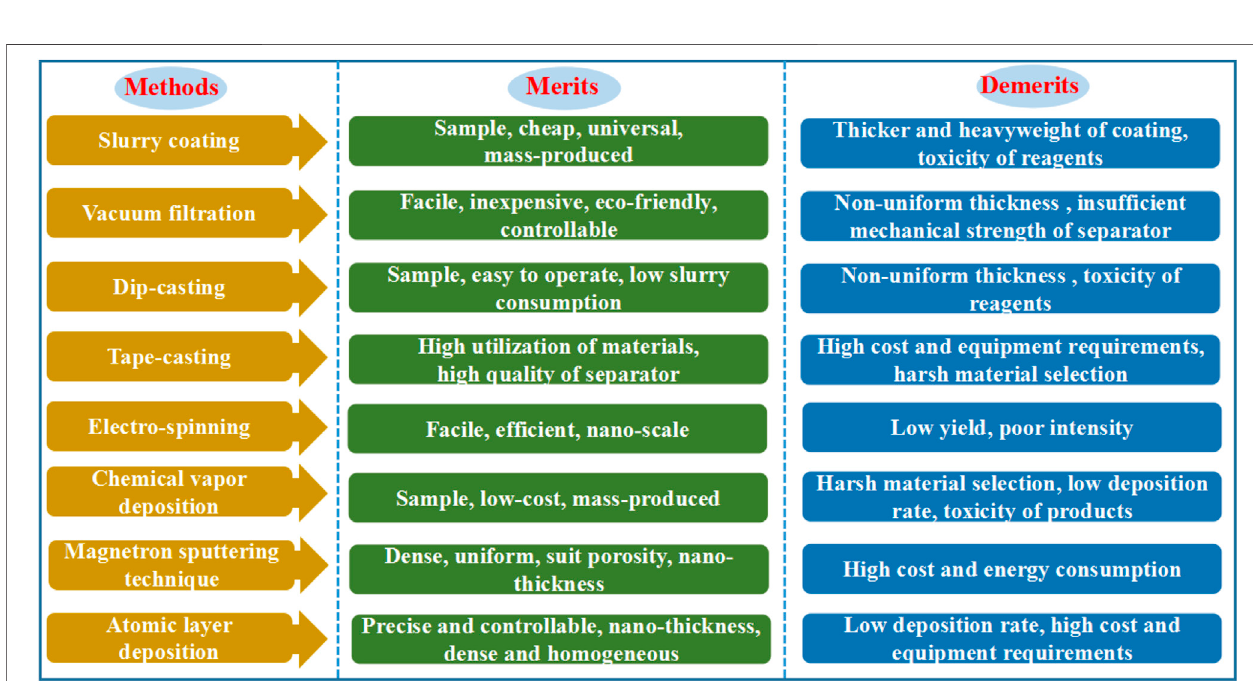
FIGURE 11 | Merits and demerits of various fabrication methods of functional separators.